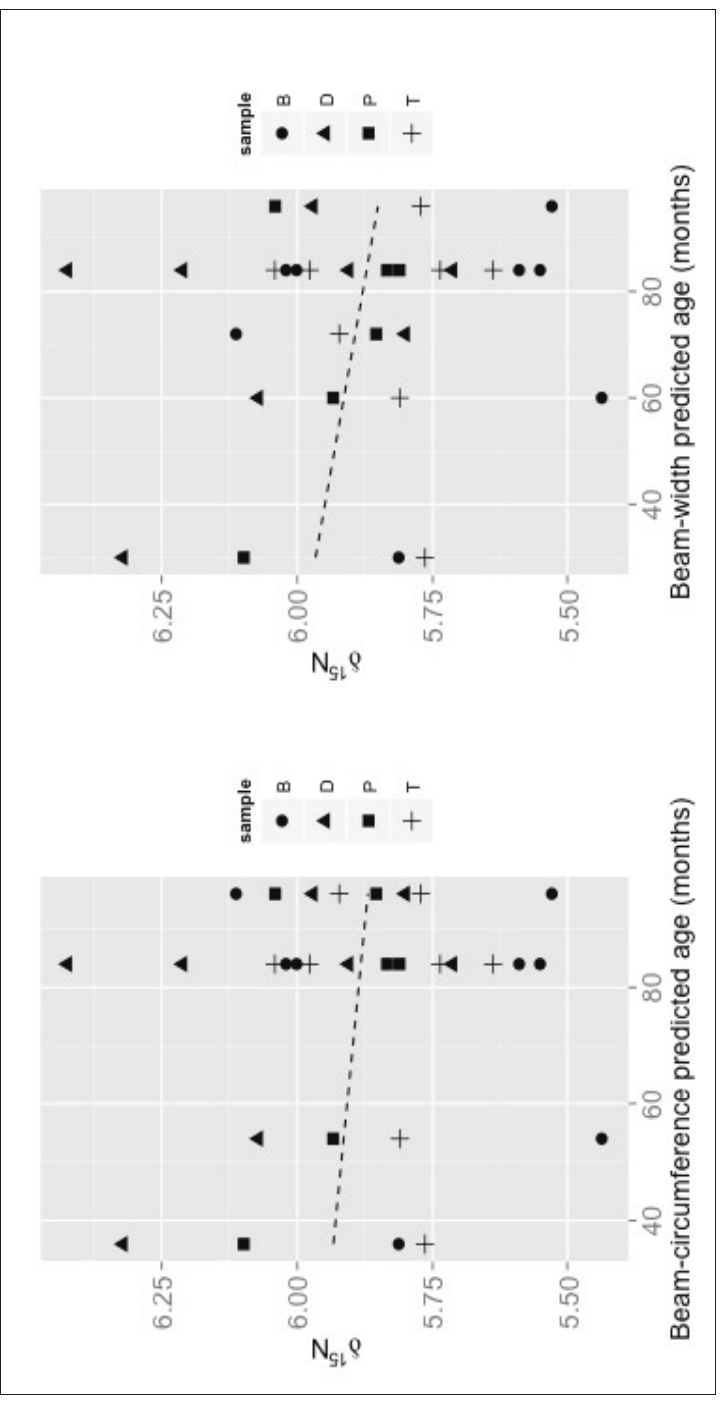
Figure 6b: Variation of δ 15 N with predicted age from Billson